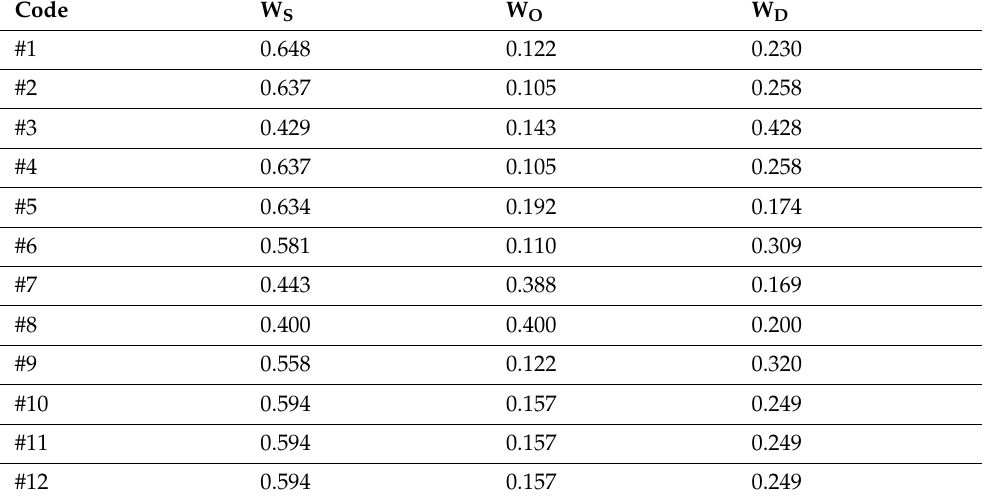
Table 6. Weight calculation result (W Si , W Oi , W Di denote the weight values of S, O, and